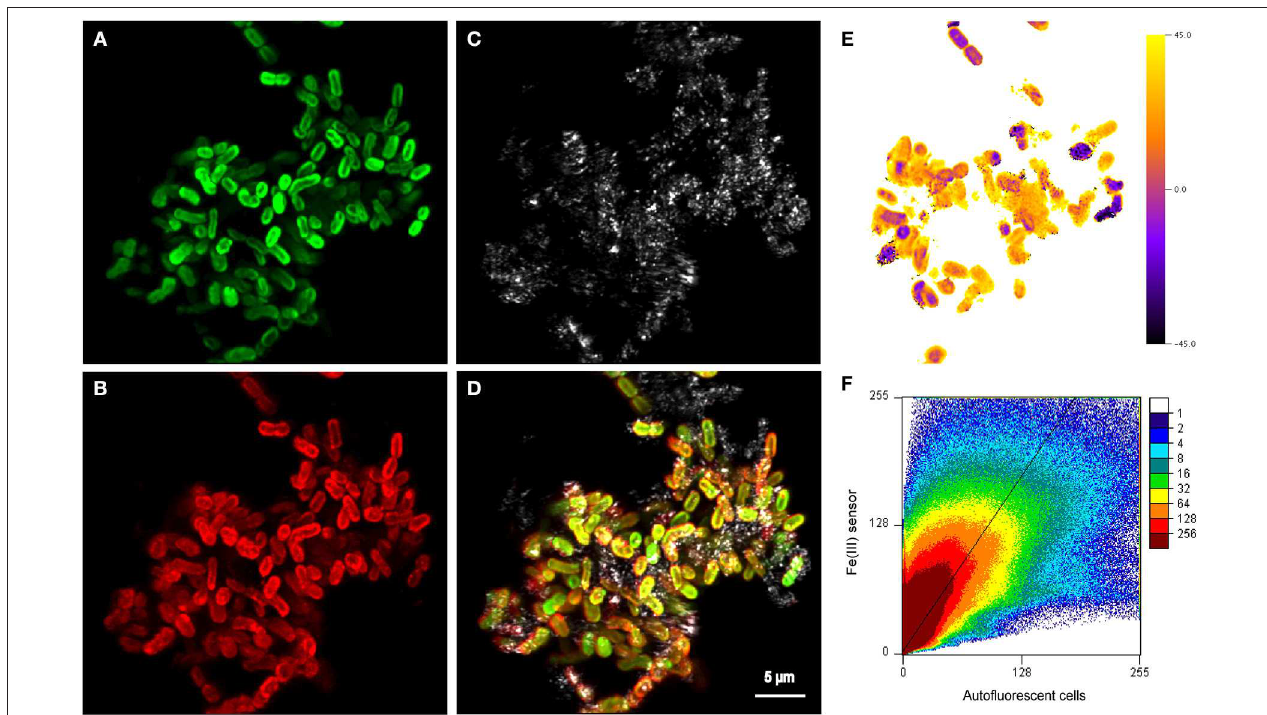
FIGURE 5 | Maximum projection of z-stacks collected on cell-mineral aggregates by CLSM showing (A) autofluorescent cells excited using the 635nm laser, (B) distribution of sorbed Fe(III) stained with the Fe(III) sensor and excited with the 488nm laser (Mao et al., 2007, 2010), (C) the reflection of the 488nm laser showing the location of mineral phases, and (D) an overlay of all three channels. (E) Single slice of the 3D angle deviation map of the Fe(III) signal from (B) and the autofluorescence signal from (A) . An angle of 0 ◦ indicates that the fluorescence signals of the respective voxel would be located on the diagonal (slope = 1) in the scatterplot (F) . Positive angles indicate an enrichment of Fe(III), whereas negative angles could be caused by both a depletion of Fe(III) or a depletion of the Fe(III) fluorescence probe. To see all slices, see the Supplementary Video associated with this publication. The very broad distribution of values in the scatterplot (F) indicates a relatively poor spatial correlation of the Fe(III) signal with the autofluorescence signal, which is also confirmed by the relatively large root mean square error (RMSE) value of 11 of the reduced major axis regression with a slope > 1 that is displayed. Units in (F) are normalized to the maximum signal of each channel.